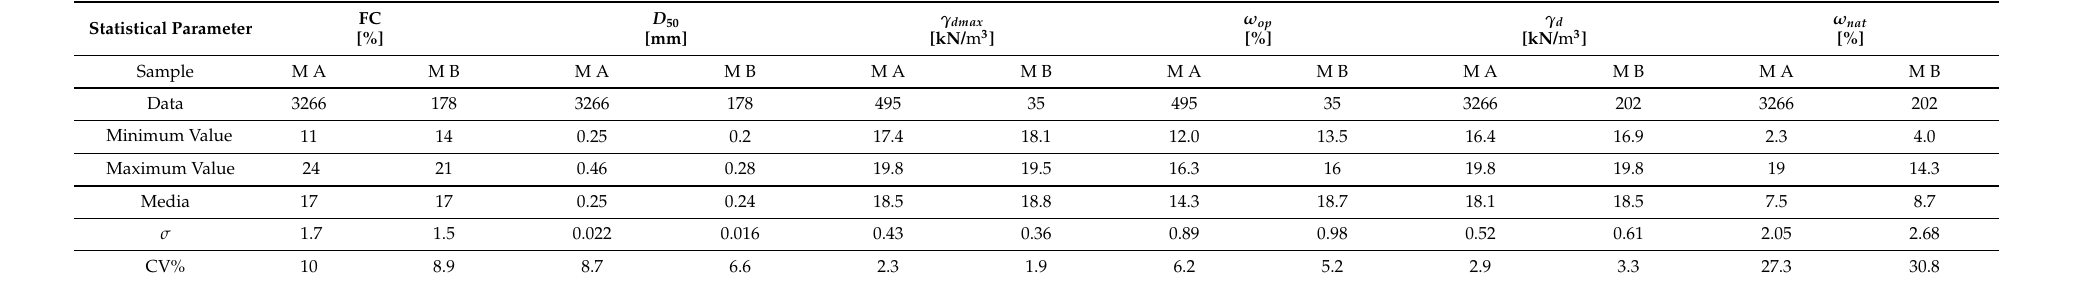
Table 4. Summary of statistics for the total sample and the study area for the embankment and classified sand tailings dam